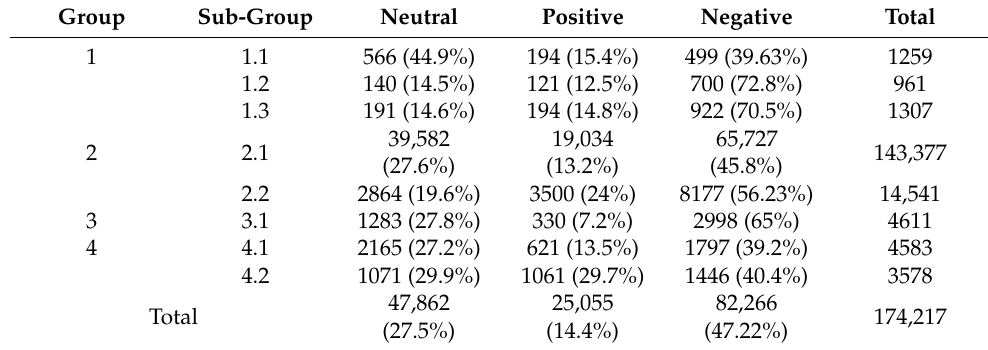
Table 2. Collected data classifications results.